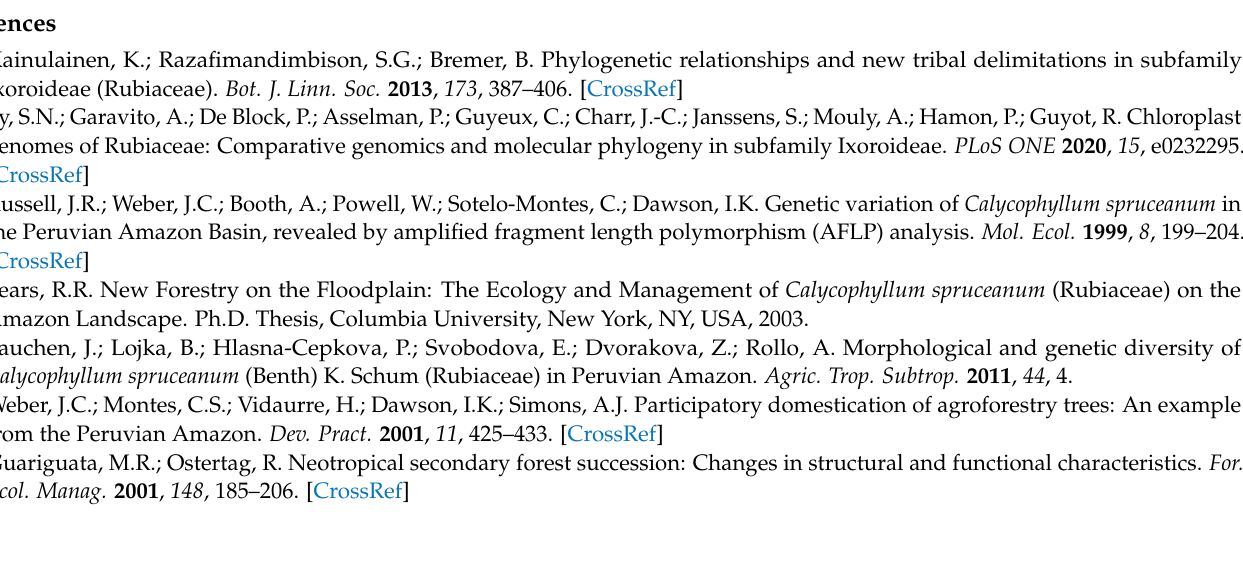
Table S2: The codon-anticodon recognition pattern and codon usage in the chloroplast genome of Calycophyllum spruceanum . Table S3: Number of different SSRs types in C. spruceanum and six other Ixoroideae species. Figure S1: Reads mapping of the chloroplast genome of C. spruceanum reassembled. Figure S2: Matrix of identities of the four regions (LSC, SSC, IRa, IRb) between each of seven chloroplast genomes. Figure S3: Comparison of the genome structure and location of the simple sequence repeat (SSR) of seven Ixoroideae cp genomes, with C. spruceanum as a reference. Figure S4: Bayesian phylogenetic tree of 19 species of the Rubiaceae family and outgroup using complete chloroplast genome sequence. Numbers above the branches represent posterior probabilities. Names given to clades refer to subfamilies. The outgroup taxon is Lonicera hispida